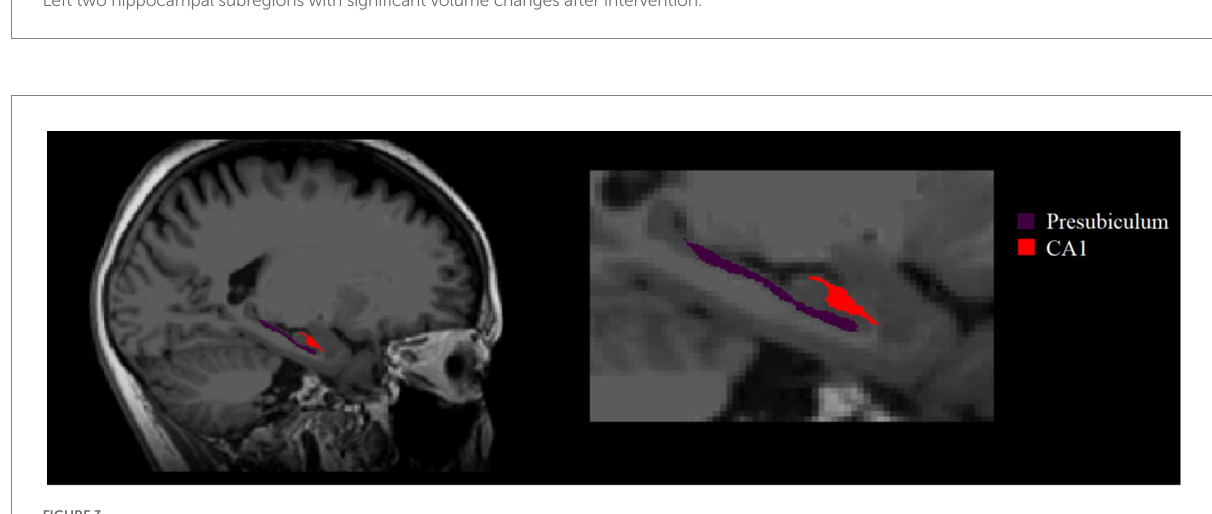
FIGURE 3 Right two hippocampal subregions with significant volume changes after intervention.